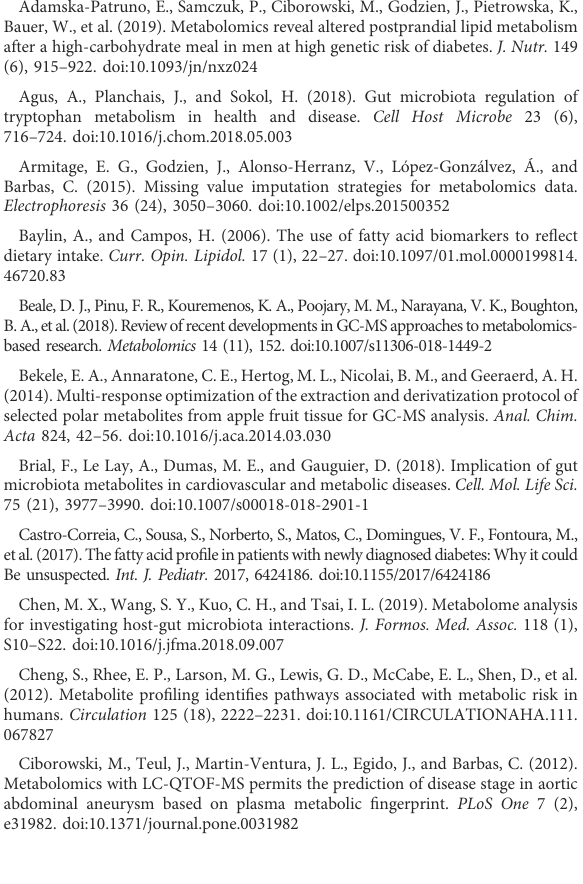
SUPPLEMENTARY TABLE S2 Repeatability and reproducibility of MDM measurments. SUPPLEMENTARY TABLE S3 Stability of MDMs in both